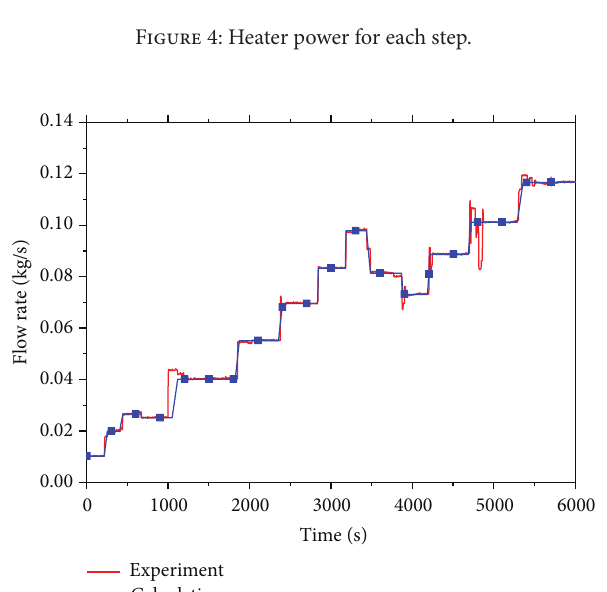
Figure 4: Heater power for each step.